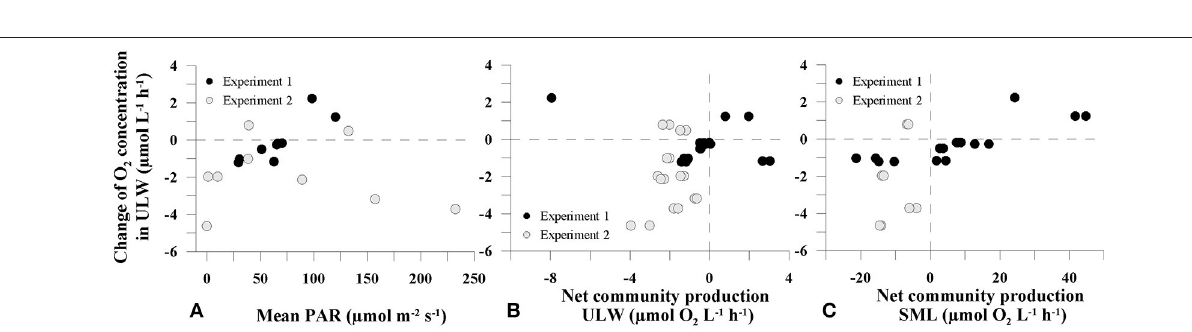
concentration of up to 30 µ mol O 2 L − 1 within a range of 500 µ m water depth (e.g., Experiment 2, Day 1, 10:26, Figure 2B ). From the gradients in the upper 1.1 mm we calculated − 0.08 µ mol O 2 L − 1 h − 1 and − 0.37 µ mol O 2 L − 1 h − 1 . The diffusive rates during Experiment 2 ranged between 0.09 µ